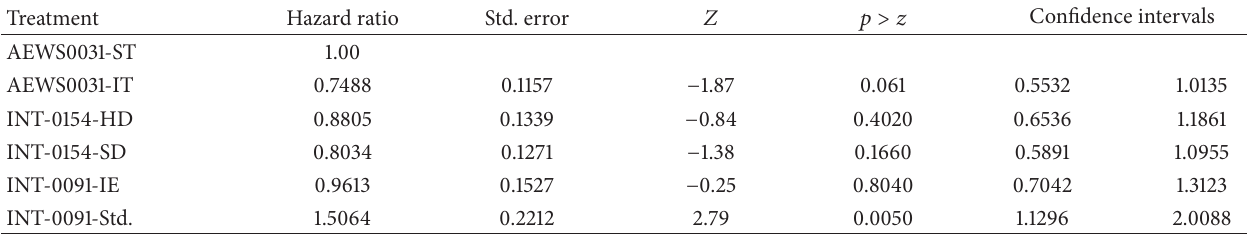
Table 2: EFS risk by treatment arm relative to standard treatment in AEWS0031.